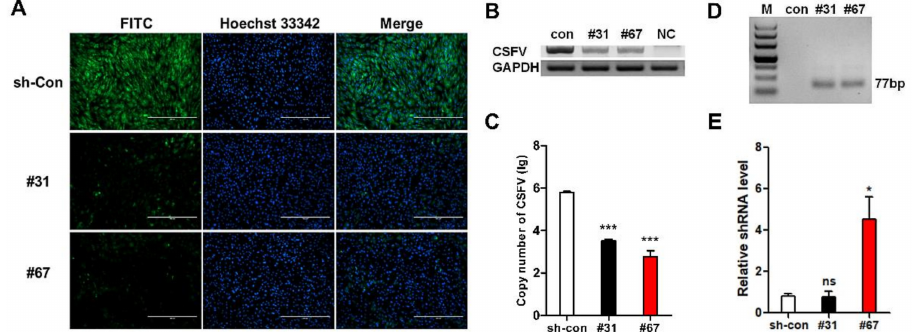
Figure 5. Verification of the antiviral ability of TG PFF clones. ( A ) Virus resistance in identified positive PFF clones #31 and #67 was examined by IFA. sh-Con: scrambled shRNA transgenic PFFs. ( B ) Antiviral ability in positive PFF clones #31 and #67 was further assessed by RT-PCR at 72 h post-infection. ( C ) qPCR results showed the copy number of CSFV virus in positive PFF clones #31 and #67. The values displayed on the Y axis are calculated in lg. All values are the mean ± S.E.M., n = 3. *** p < 0.001. ( D ) Expression of the target siRNA in corresponding positive PFFs clones #31 and #67 was further confirmed by RT-PCR. M: 50 bp DNA ladder. ( E ) Relative expression level of anti-CSFV shRNA in positive PFF clones #31 and #67 were confirmed by qPCR. All values are the mean ± S.E.M., n = 3. ns, not significant. * p <